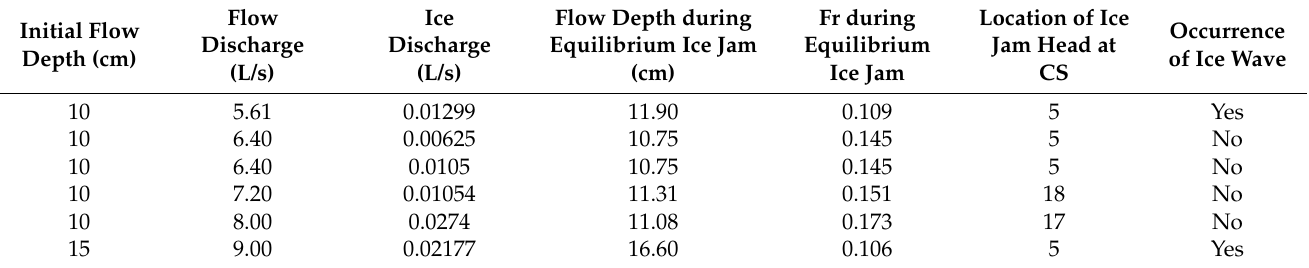
Table 2. Hydraulic conditions for 21 experiment runs with and without presence of ice